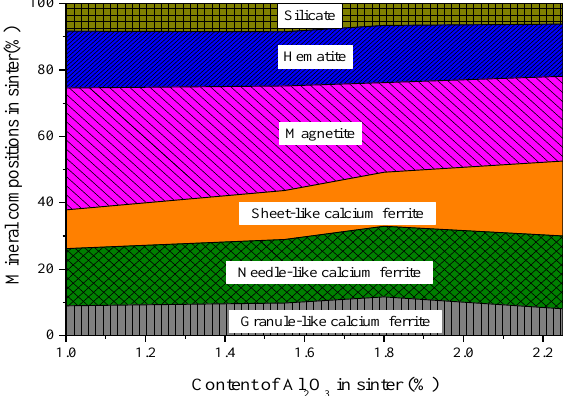
ff ects of Al 2 O 3 content on mineral Figure 6. Effects of Al 2 O 3 content on mineral composition. Figure 6. E Figure 6. Effects of Al 2 O 3 content on mineral composition.